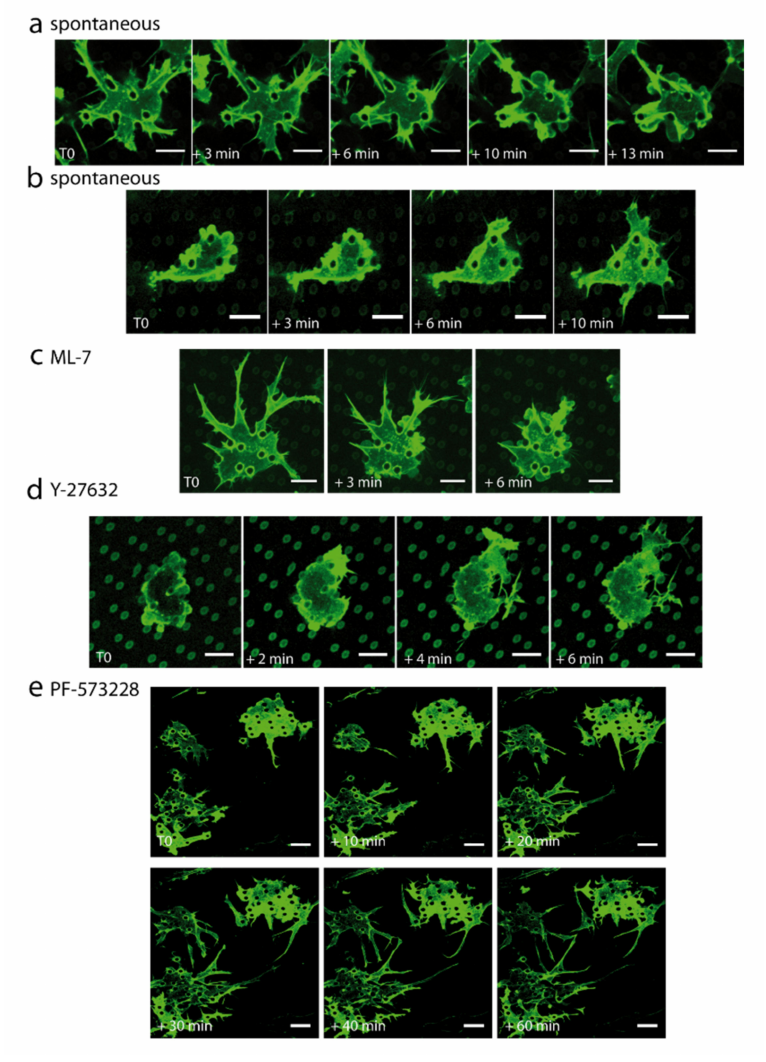
Figure 7. Transition between different protrusive modes in the microstructures, and molecular mechanisms. ( a , b ) Spontaneous transitions between an amoeboid state and a mesenchymal state ( a ), and between a mesenchymal and an amoeboid state ( b ). ( c – e ) Kinetics of the representative effects of ( c ) ML-7 (10 µ M), ( d ) Y-27632 (10 µ M), or ( e ) PF-573228 (10 µ M) addition on Lifeact-GFP HUVECs cells (green, Lifeact-GFP), z projection of the bottom planes. ( a , b ) T0 refers to an arbitrary moment chosen as time origin, ( c – e ) T0 refers to the time of drug addition. Movies were acquired 1 day after cell seeding. Scale bar 10 µ m ( a – d ), 15 µ m ( e